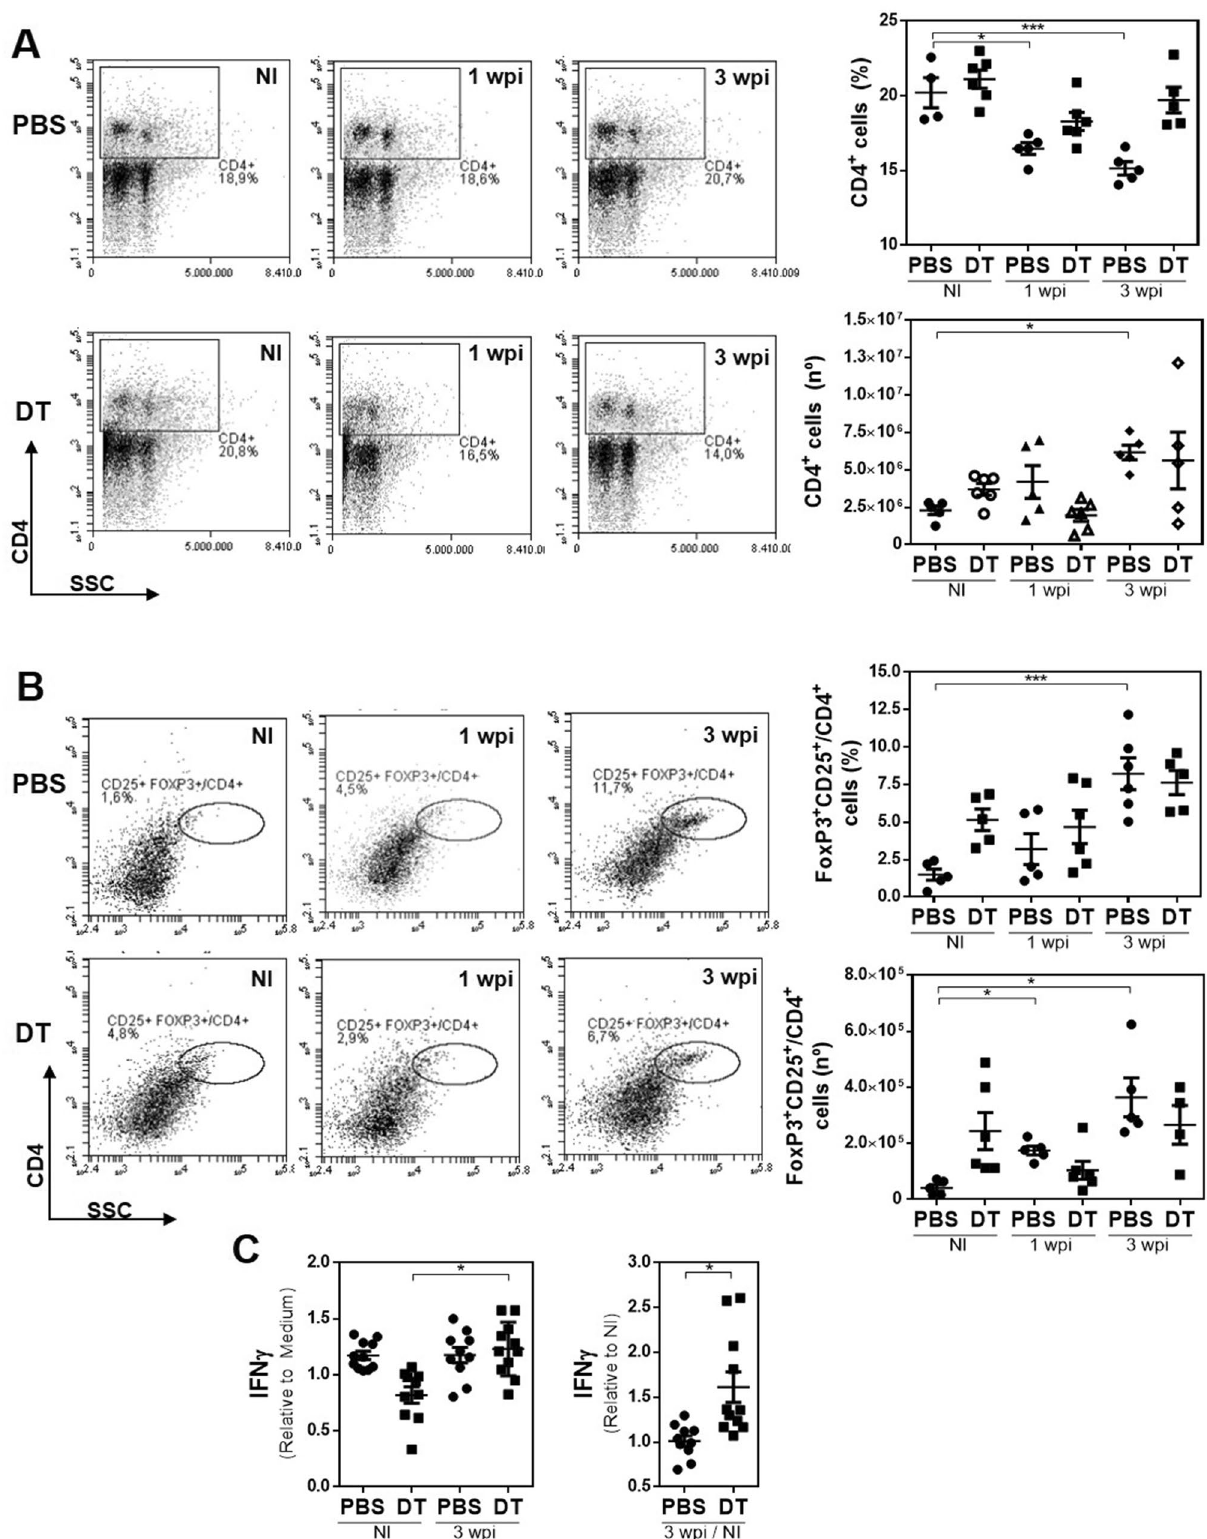
Figure 6. Depletion of F4/80 + MGL2 + cells during F. hepatica infection abrogates splenic Treg expansion. Frequency and number of CD4 + cells ( A ) and FoxP3 + CD25 + /CD4 + cells. ( B ) in spleens were determined by flow cytometry. MGL2-DTR mice were infected with 10 F. hepatica metacercariae and sacrificed at 1 dpi, 1 or 3 wpi. MGL2 + cells were depleted with DT-treatment. Control mice were injected with PBS. Non infected mice were used as controls (NI). ( C ) Production of IFNγ evaluated by specific ELISA on supernatants of splenocyte culture stimulated with PMA/Ionomicin. A representative figure of three independent experiments is shown (± SEM, indicated by error bars). Asterisks indicate statistically significant differences (* p < 0.05, *** p <